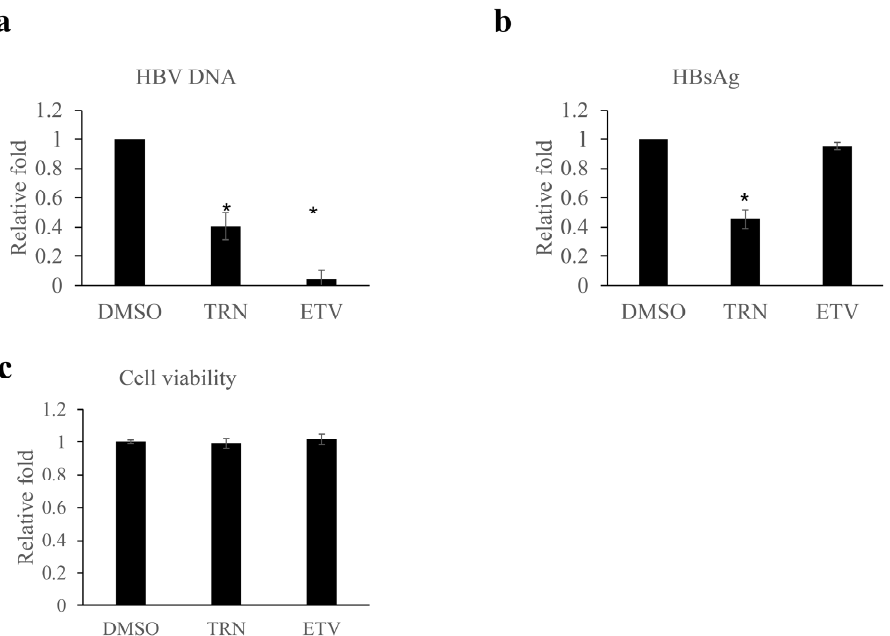
Figure 2. Effect of tranilast on anti-HBV activity in HepG2.2.15.7 cells. ( a ) Cells were treated